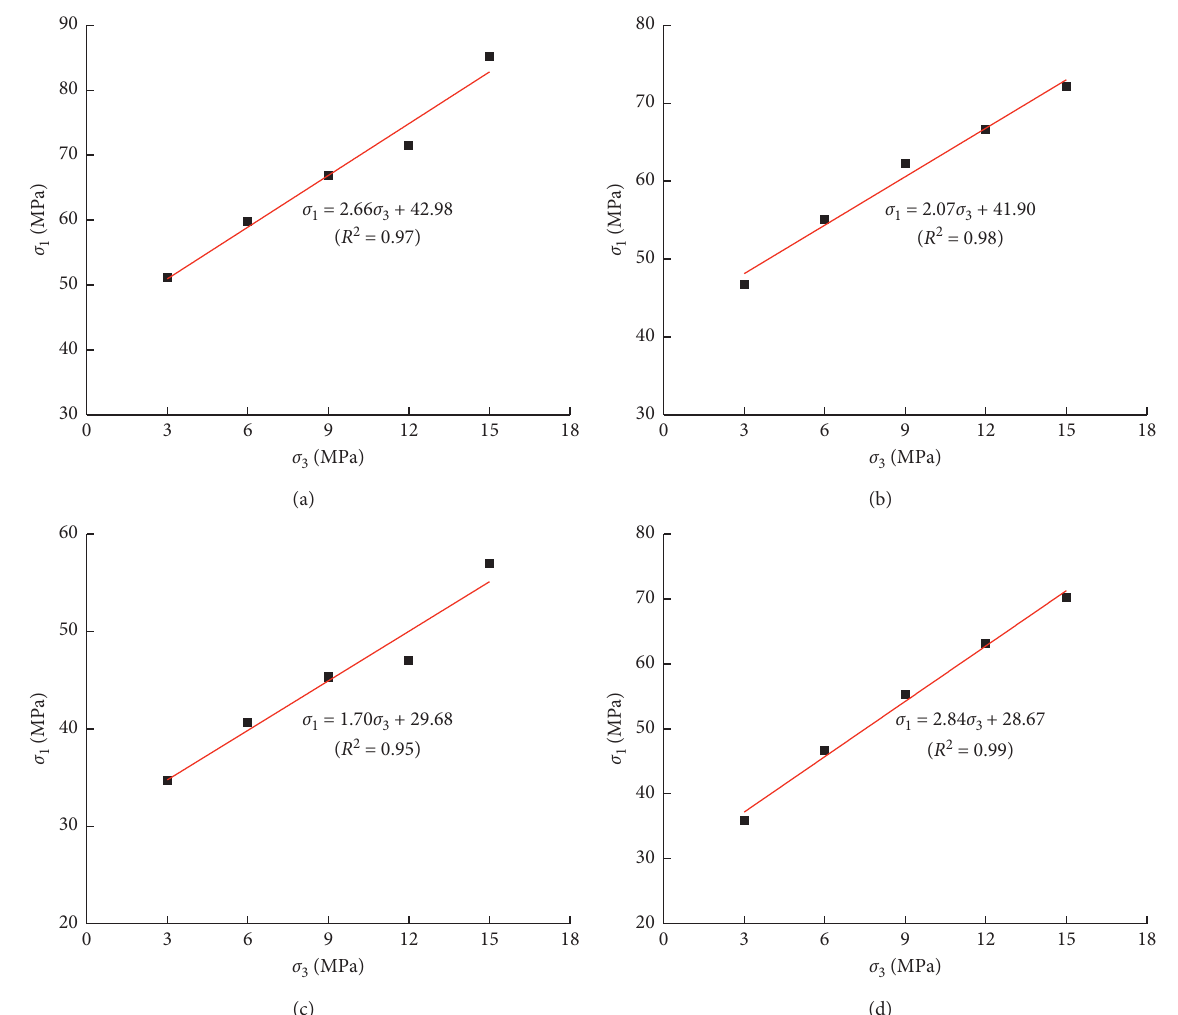
Figure 8: Relationship curve between peak strength and confining pressure of each group of samples under triaxial compression. (a) Natural. (b) Dehydration at 45 ° C. (c) Water saturation. (d) High-temperature dehydration at 220 ° C.